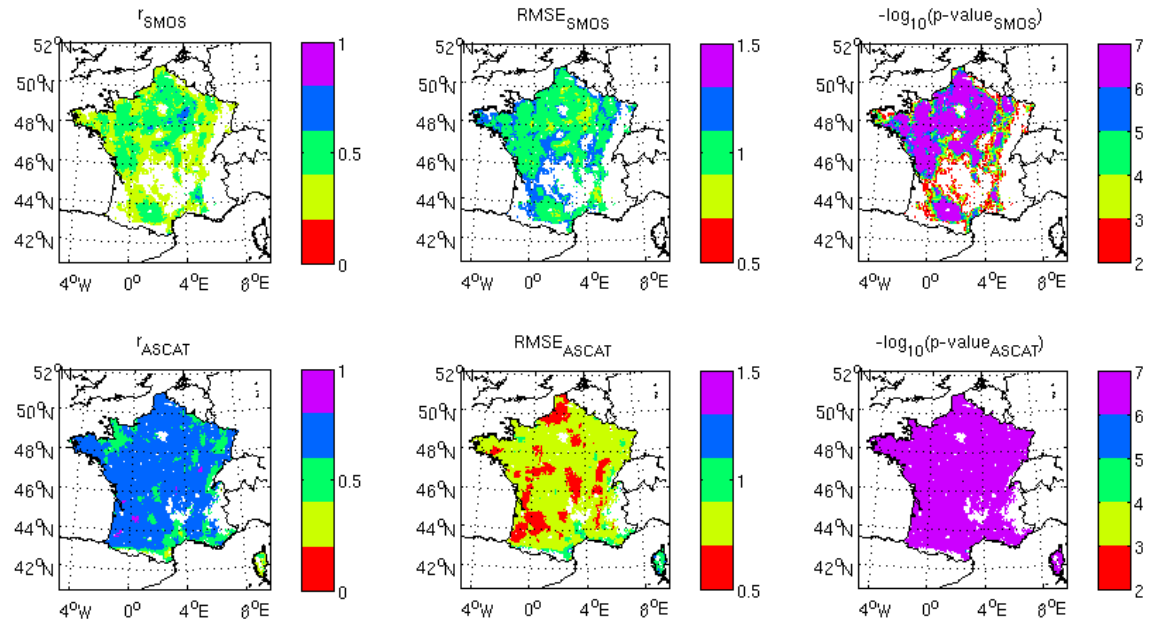
Fig. 4. Comparison between SMOS-L2 and ASCAT SSM anomalies with SSM anomalies calculated by ISBA-A-gs. From left to right: correlation coefficient ( r ), root mean square error (RMSE), and p-value, for (top panel) SMOS-L2, and (bottom panel) ASCAT. Blanked areas are mountainous or urban areas and areas presenting a non-significant score (p-value > 0.05).